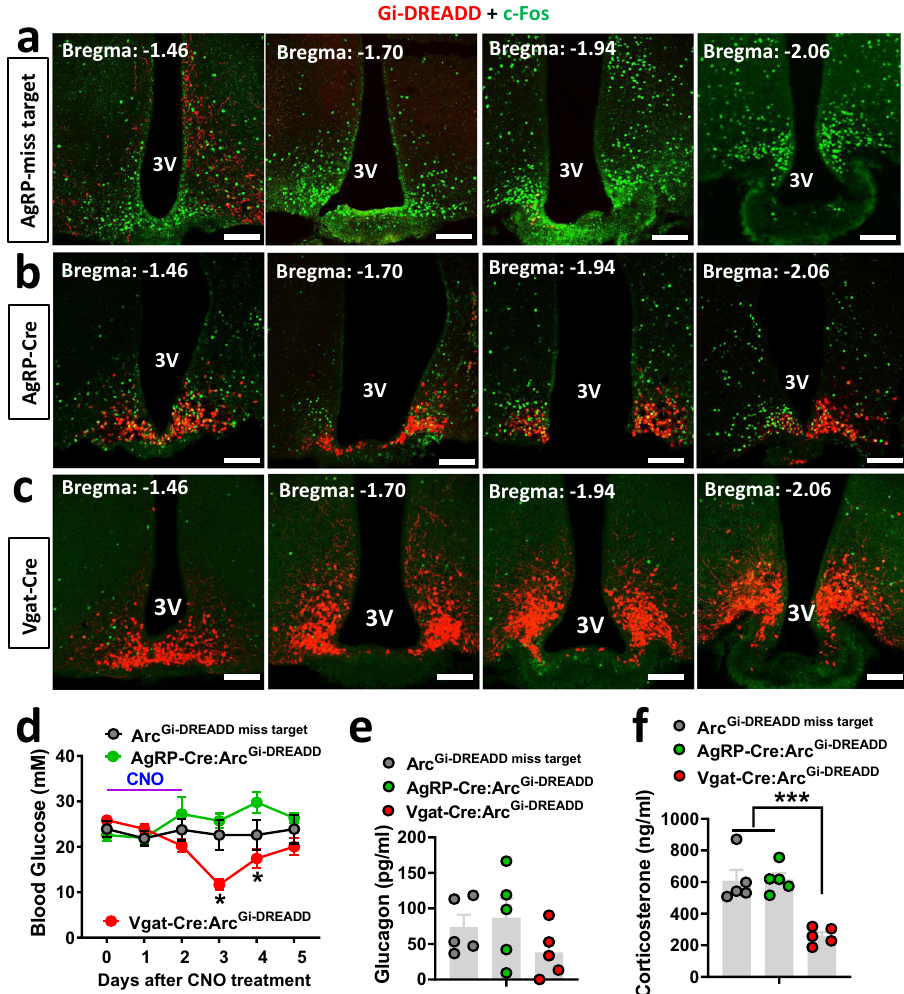
Fig. 3 Acute inhibition of Arc neurons on T1D glucose. AgRP-Cre or Vgat-Cre mice were injected with AAV-DIO-h4MD(Gi)-mCherry vectors to bilateral Arc and then were made STZ-T1D. a – c Series of sections spanning the Arc showing speci fi c expression of viral vector expression (red) and c-Fos expression (green) in mistargeted mice ( a ), AgRP-Cre ( b ), and Vgat-Cre mice ( c ). Representative pictures over 3 repeats. d – f Comparisons in blood glucose in the indicated groups of mice in response to a 3-day CNO treatment protocol (twice daily for 3 days) ( d , two-way ANOVA, n = 5/each, F (2, 75) = 16.41, * P < 0.0001, AgRP-Gi-DREADD vs Vgat-Cre-Gi-DREADD at day 3; * P < 0.0001, missed vs Vgat-Cre-Gi-DREADD at day 3), comparisons in corticosterone ( e , one-way ANOVA, n = 5/each, F (2, 12) = 1.449, P = 0.4774, missed vs Vgat-Cre-Gi-DREADD at day 3) and glucagon ( f , one-way ANOVA, n = 5/each, F (2, 12) = 18.93, *** P = 0.0005, Vgat-Gi-DREADD vs missed; *** P = 0.0005, Vgat-Gi-DREADD vs AgRP-Gi-DREADD) at day 3 after the initiation of CNO treatment. 3V the third ventricle, Arc arcuate nucleus. All data presented as mean ± SEM. Scale bar: 100 µ and function, we fi rst delivered the virus to one side of the Arc (Fig. 4a, left panels) of AgRP-Cre (top panels) or Vgat-Cre mice (bottom panels). In T1D, as expected, the noninjected side exhibited abundant c-Fos, while the injected side showed sig- ni fi cantly reduced levels of c-Fos expression (Fig. 4a, middle and right panels). These results suggest that Kir2.1 expression leads to chronic neuron inhibition.